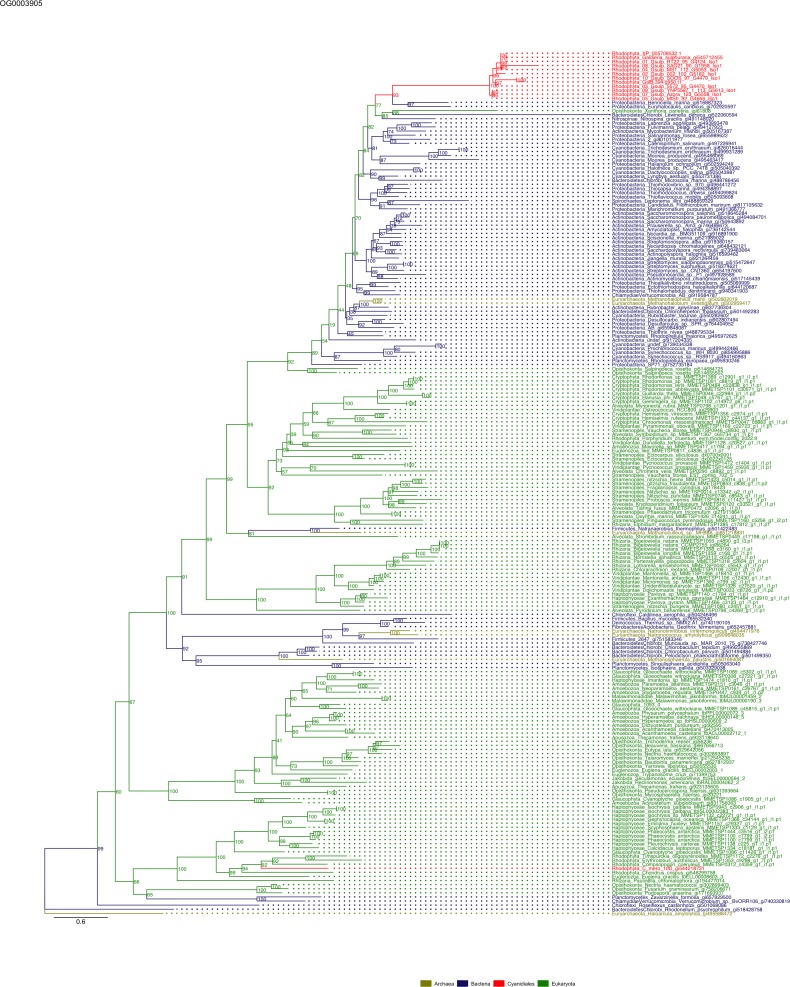
Sequence tree of orthogroup OG0003905.The tree is based on amino acid sequences. Archaea (yellow), Bacteria (blue), Cyanidiales (red), Eukaryotes including other red algae (green). Branches containing Cyanidiales sequences are highlited in red.